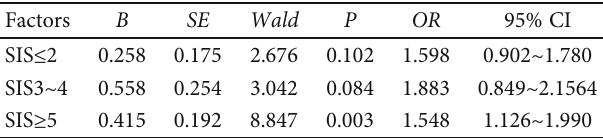
Table 9: Multivariate COX analysis of the relationship between SIS score and stroke in patients with